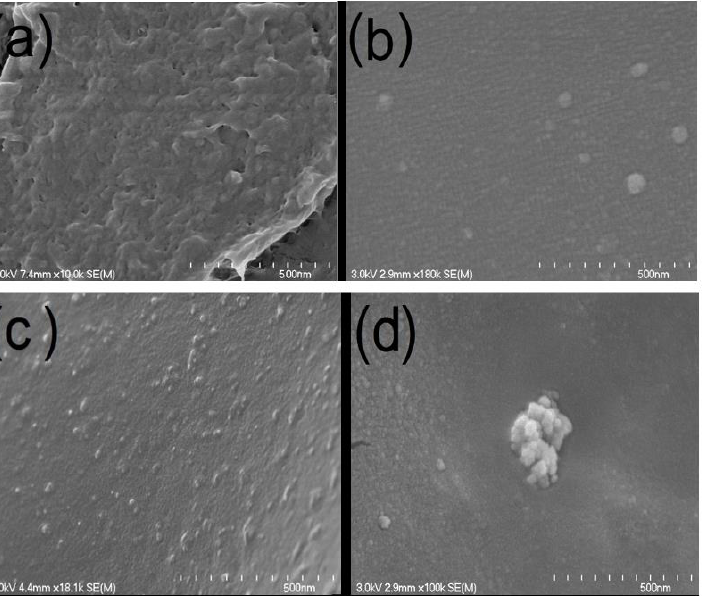
Figure 2. SEM images of: ( a ) neat PLA, ( b ) PLA/g-SNC (3 wt%), ( c ) PLA/g-SNC (5 wt%), and ( d ) PLA/g-SNC (7 wt%) nanocomposites.